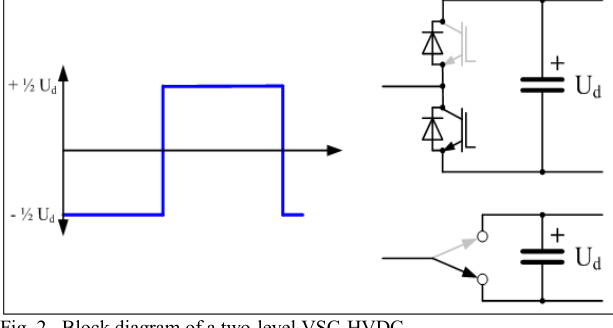
Fig. 2. Block diagram of a two-level